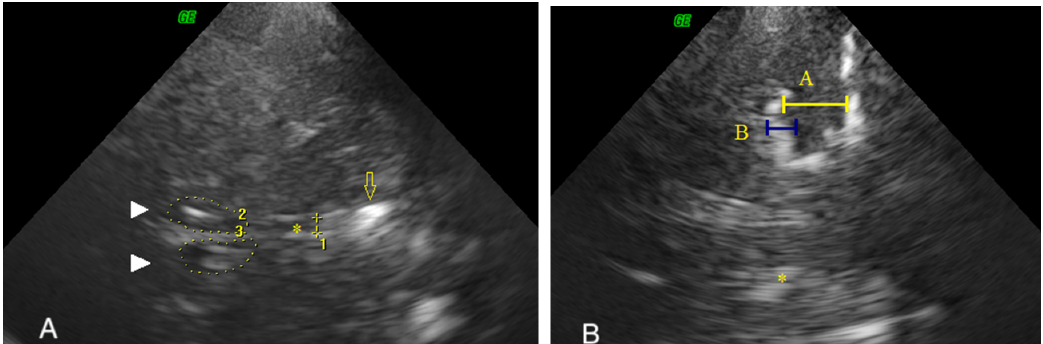
Figure 2. Ultrasound measurements of the third ventricle ( A ) and of the ( B ) medial temporal lobe on transcranial sonography. Brain structures visualized in axial plane (Figure 2A): arrowhead (2,3)—lateral ventricles; arrow—pineal gland; asterisk (1) —the third ventricle. Brain structures visualized in coronal plane (Figure 2B): A—height of the MTL, B—height of the choroidal fissure; asterisk—third ventricle.